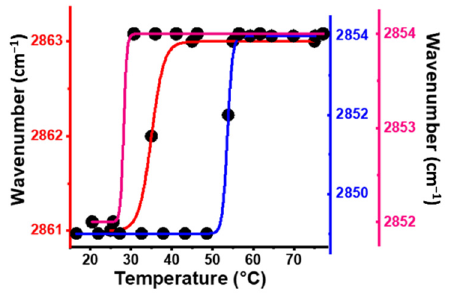
Figure 5. Comparison of the temperature dependence of the frequency of the ν s (CH 2 ) band in the infrared spectra of dried DPPTE lipid on the gold layer (blue line), on the L1 gold nanoantennas (red line) and on the gold nanoparticles (magenta line).